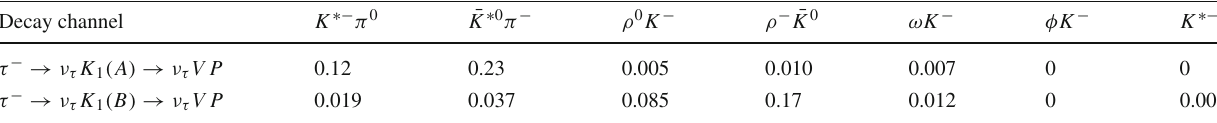
Table 9 Branching ratios (in %) for the (cid:14)(τ → ν τ A → ν τ V P ) process for the I = 1 / 2 intermediate axial-vector resonances. The results have an uncertainty of 40% Decay channel K ∗− π 0